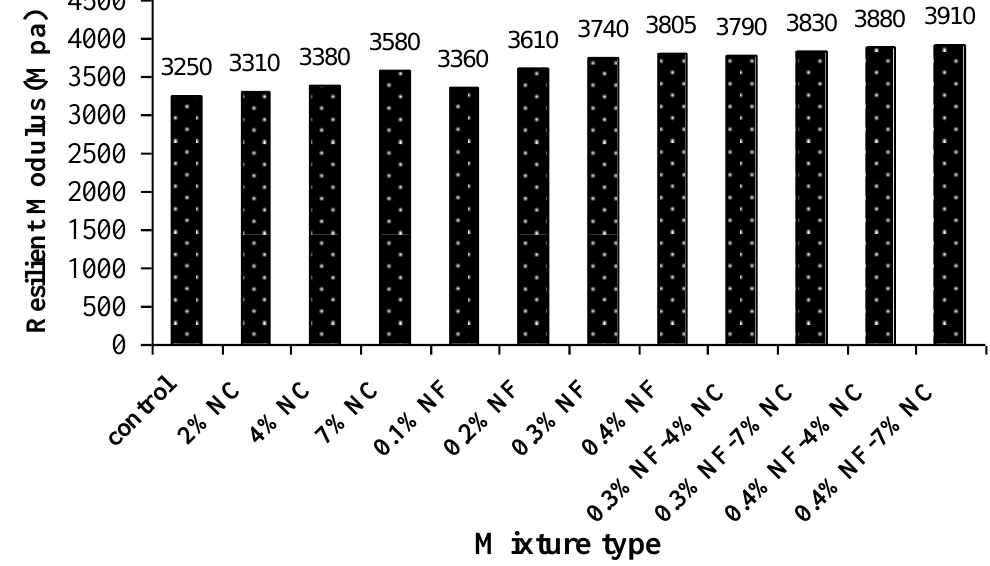
Fig. 6. Resilient modulus tests